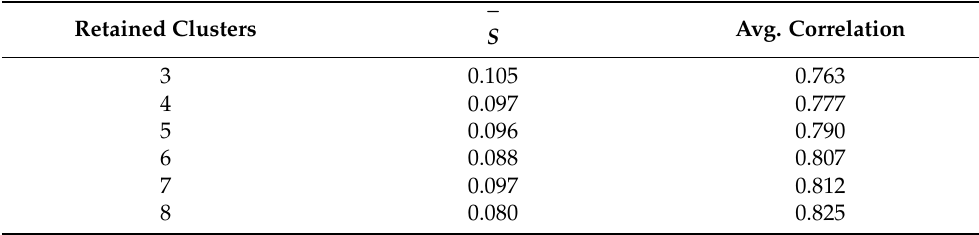
Table 1. Baseline cluster analysis (no KPCA) for each number of retained